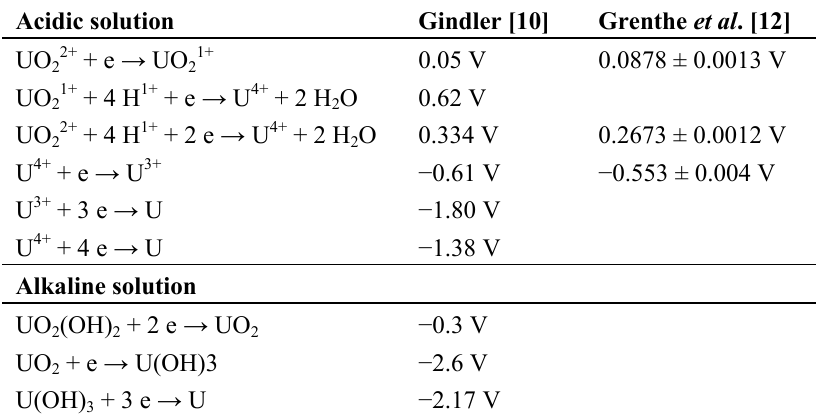
Table 5. Standard reduction